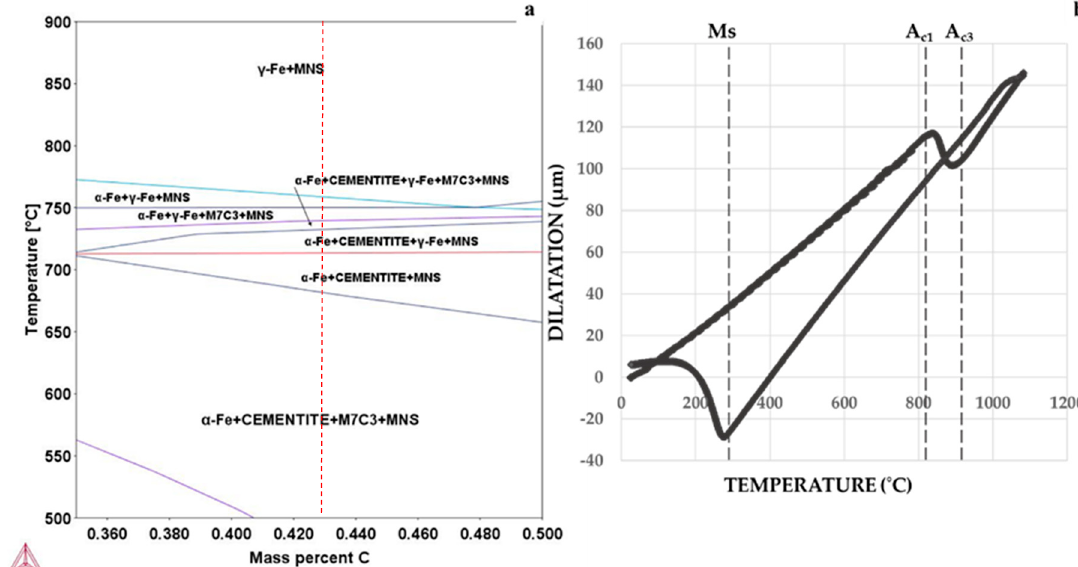
Figure 2. ( a ) Isopleth of the phase diagram of CrMo steel calculated using Thermocalc ® . The dashed line indicates the C content, ( b ) Temperature-Dilatation graph for the UFH sample measured with a heating rate of 300 °C/s and cooling rate of 100 °C/s. The transformation temperatures (A c1 , A c3 , M s ) derived from this diagram.